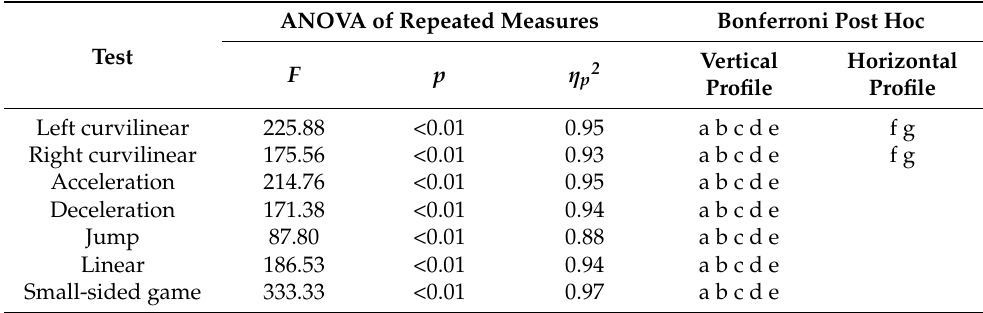
Table 1. Differences in the multi-location external workload profile in the most common movements in basketball. ANOVA of Repeated Measures Bonferroni Post Hoc Test Vertical Horizontal F p η p2 Profile Profile Left curvilinear 225.88 <0.01 0.95 a b c d e f g Right curvilinear 175.56 <0.01 0.93 a b c d e f g Acceleration 214.76 <0.01 0.95 a b c d e Deceleration 171.38 <0.01 0.94 a b c d e Jump 87.80 <0.01 0.88 a b c d e Linear 186.53 <0.01 0.94 a b c d e Small-sided game 333.33 <0.01 0.97 a b c d